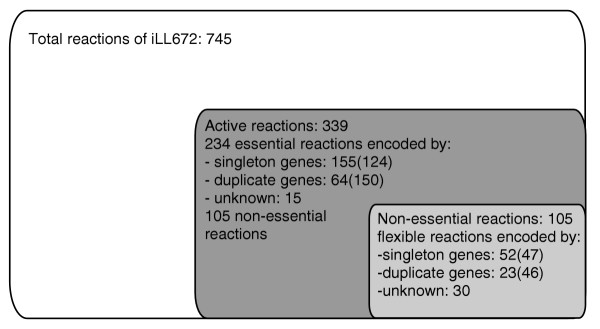
Genome-wide proportion of active, essential and flexible metabolic reactions during growth of S. cerevisiae (iLL672) on glucose. Flexible reactions are defined as having a non-zero flux but are not essential for growth. The number of genes that encode biochemical reactions is given in parentheses.